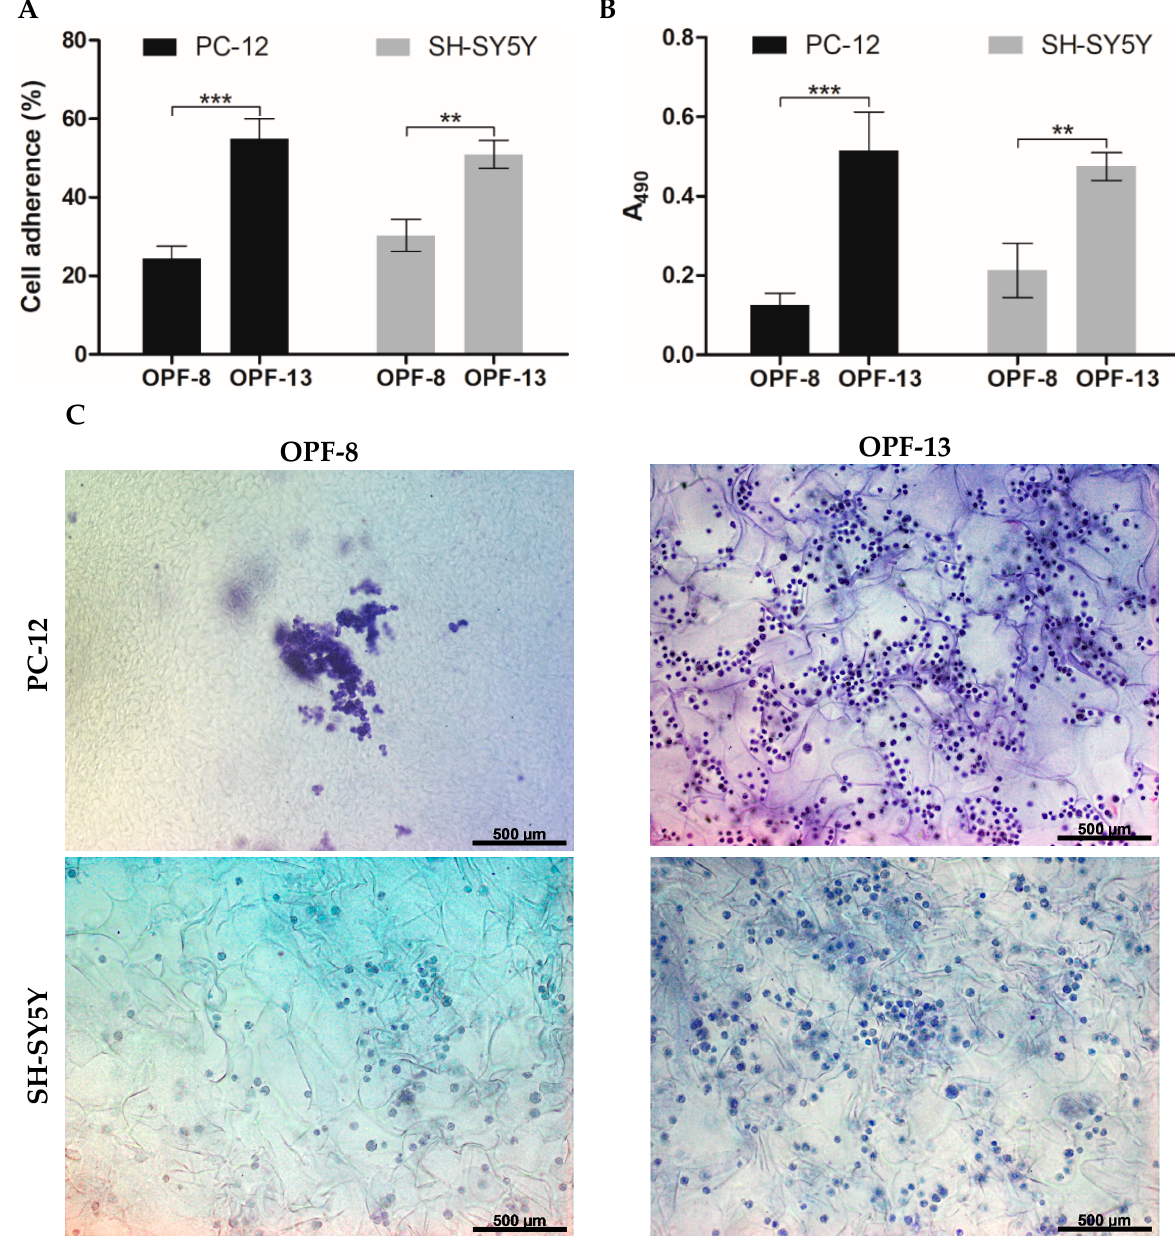
Figure 5. ( A ) Cell adherence on OPF cryogels after 4 h of incubation (% relative to the total number of seeded cells). ( B ) Proliferation of PC-12 and SH-SY5Y on OPF cryogels determined by an MTS assay at day 3 post-seeding. The data are presented as mean ± SD ( n = 3, ** p < 0.01, and *** p < 0.001). ( C ) Representative bright-field microscopy images of PC-12 and SH-SY5Y cells, fixed and